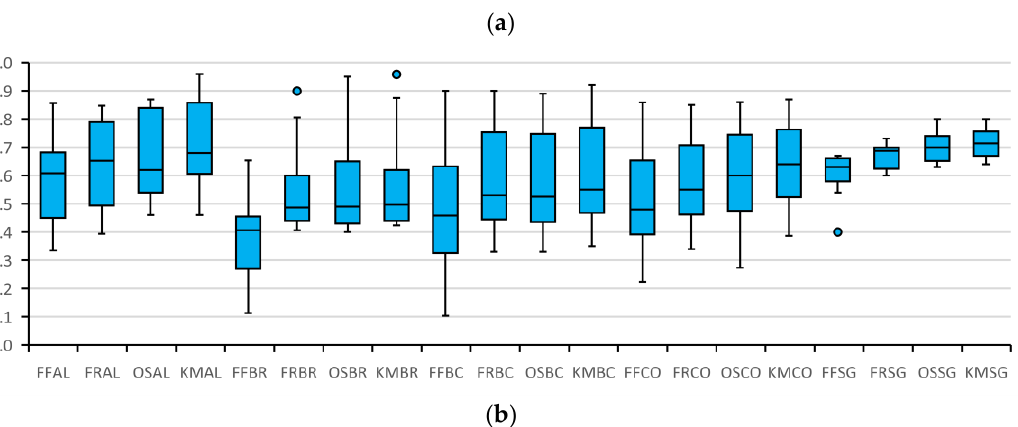
Figure 33. Box-plot of the overall accuracy of all highly illuminated and low contrast benthic habitat images segmentation results based on the proposed algorithms: ( a ) F1-score; ( b ) IOU results. AL: algae, BR: brown Algae, BC: blue Corals, CO: corals, and SG: seagrass.